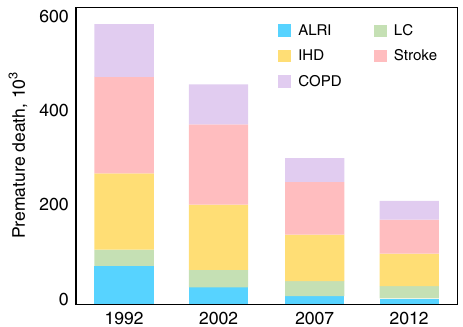
Fig. 3 Model-calculated population risk associated with exposure to PM 2.5 originating from rural residential emissions from 1992 to 2012. The results are shown for chronic obstructive pulmonary disease (COPD), cerebrovascular disease (stroke), ischaemic heart disease (IHD), lung cancer (LC), and acute lower respiratory infections (ALRIs). Source data are